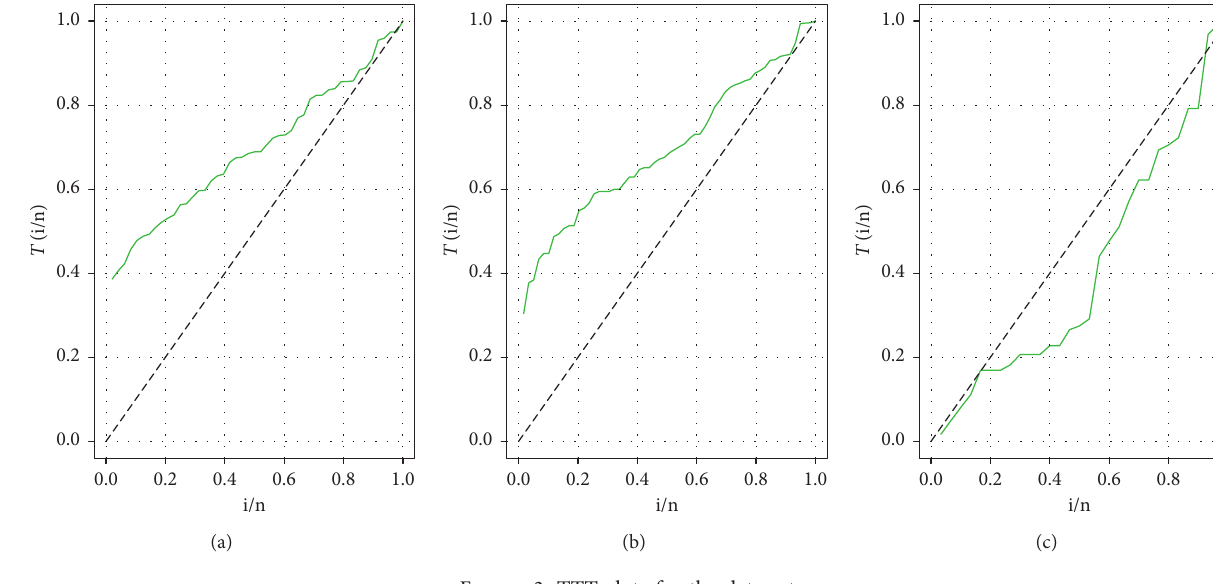
Figure 3: TTT plots for the data